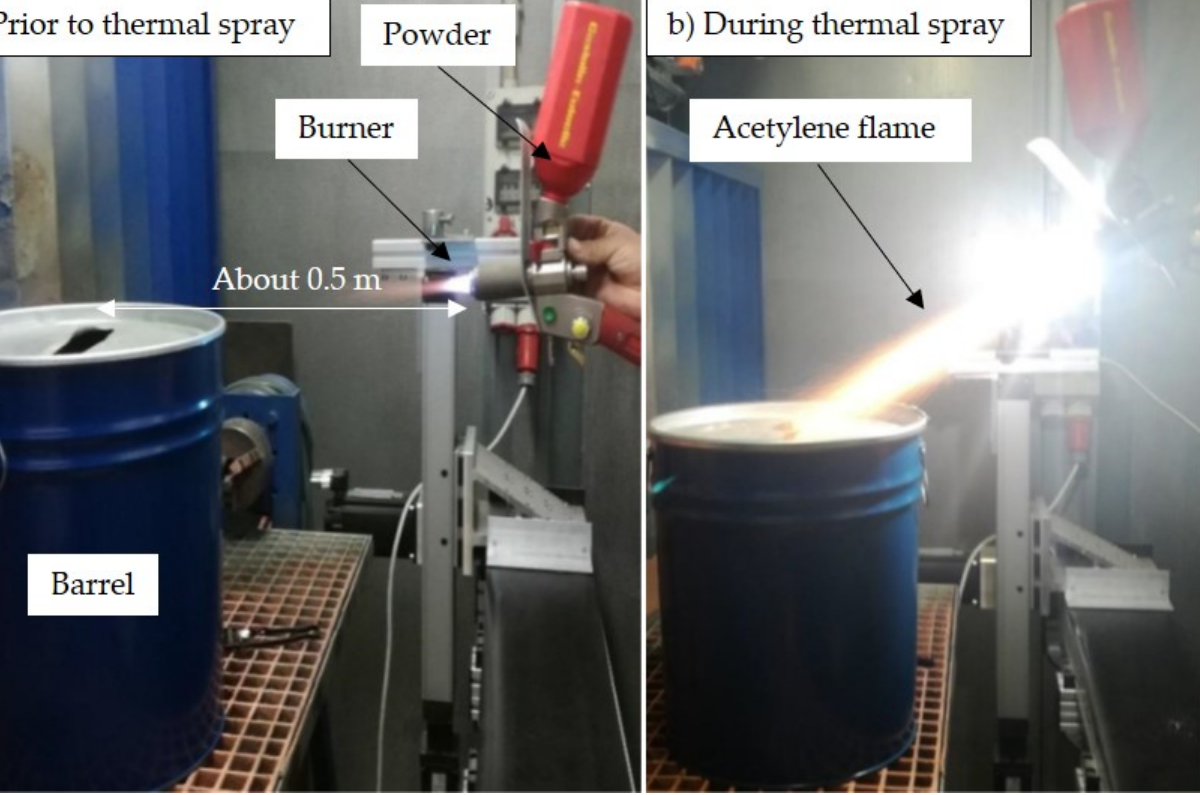
Figure 3. Experimental setup of thermal spraying: ( a ) prior and ( b ) during powder